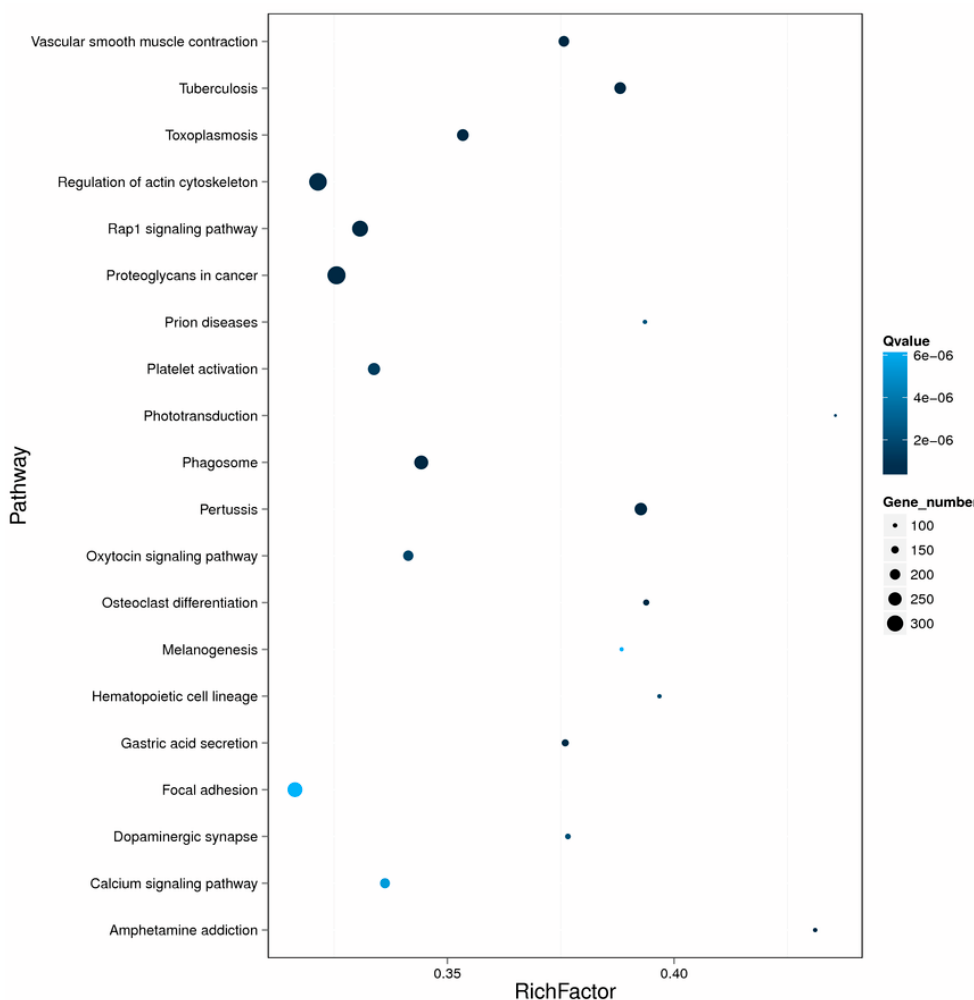
Figure 7. Enrichment of differentially expressed genes and pathways. The x -axis represents enrichment factor and the y-axis represents the pathway name. Coloring represents the Qvalue (high: white, low: blue), the lower Qvalue represents the more significant enrichment. The point size represents the differentially expressed genes number (more: big, less: small).